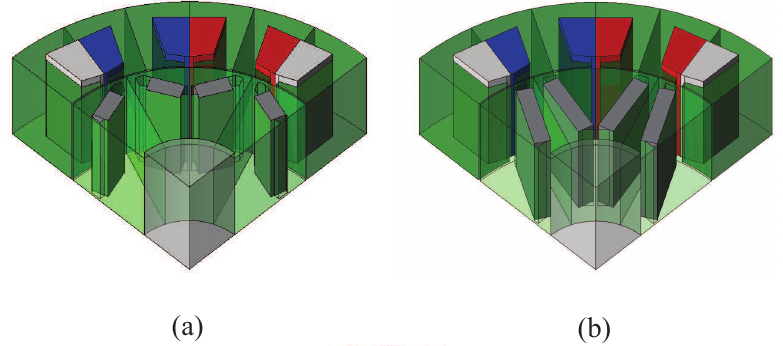
(c) Figure 5. IPM 3D-FEM models: ( a ) V-shaped interior PMs ( w m = 15 mm); ( b ) V-shaped interior PMs ( w m = 30 mm); ( c ) Straight interior PMs ( w m = 40 mm). could be present in the air gap due to the armature reaction (assuming sinusoidal phase currents)